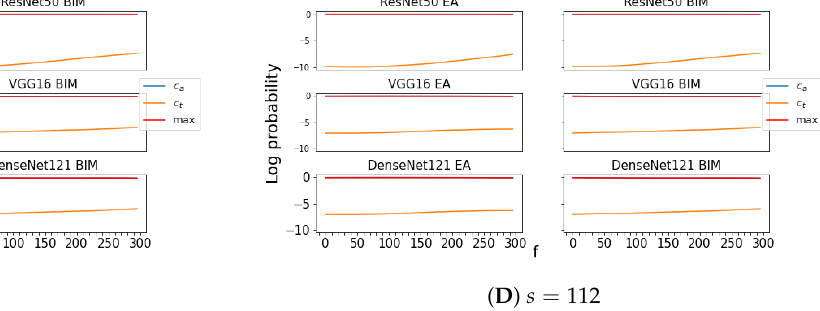
Figure A6. Evolution of c a and c t for A 4 fed to C 6 , C 9 and C 1 (first, second, and third rows of each set of graphs, respectively). In each set of graphs, the unshuffled or shuffled ancestor is perturbed with random normal noise created using the minimum and maximum noise magnitude of D EA attenuated or amplified by a factor f ( noise × f ).